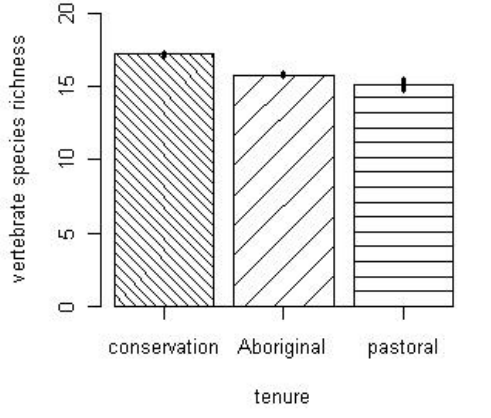
Figure 2. Variation amongst land tenures (conservation reserves, Indigenous (Aboriginal) lands and pastoral lands) in the richness and abundance of vertebrate groups. Bars show means and whiskers standard errors, based on model averaging with all covariates